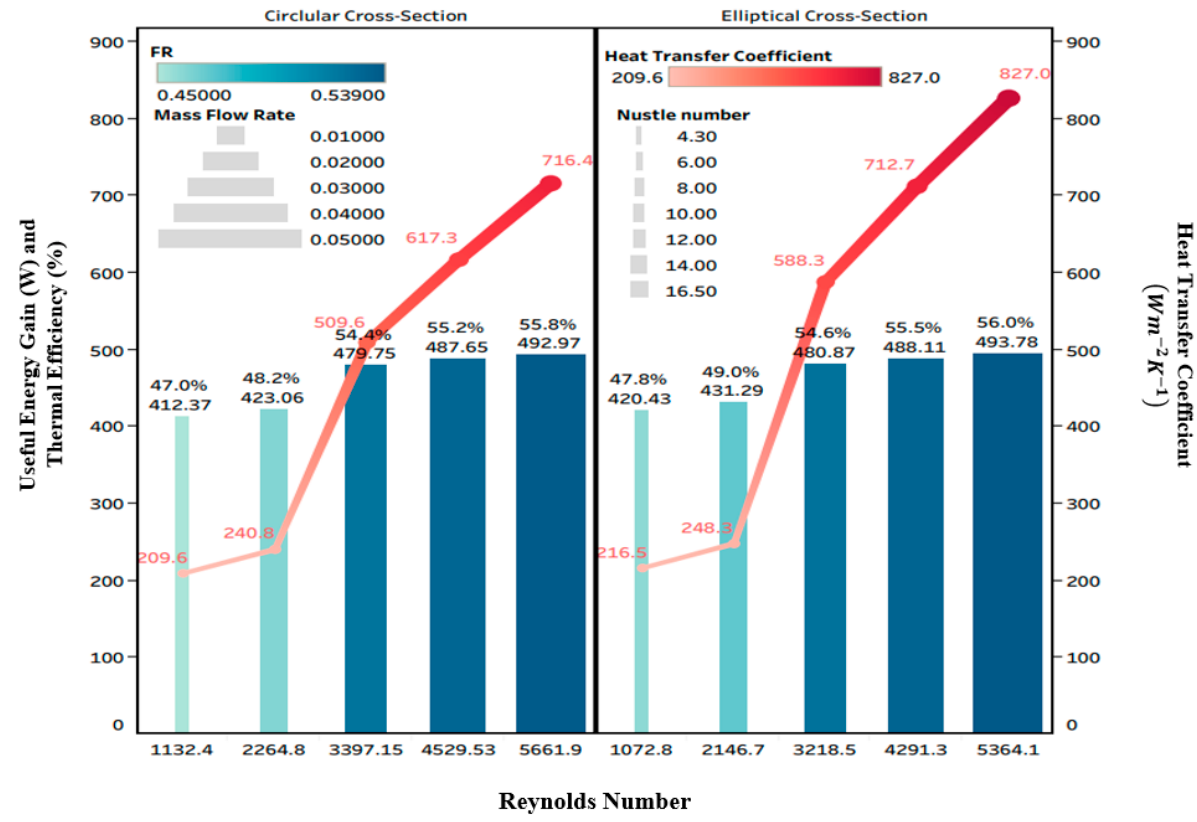
Figure 10. Schematic diagram of governing parameters affecting 𝜇 (cid:3021)(cid:3035) .